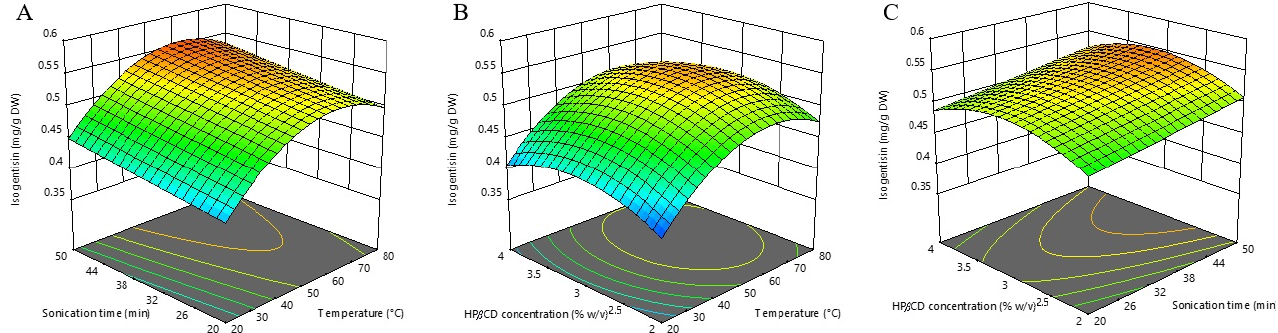
Figure 3. Three-dimensional response surfaces plots of isogentisin as a function of sonication time/temperature ( A ); hydroxypropyl- β -cyclodextrin (HP β CD) concentration/temperature ( B ); and HP β CD concentration/sonication time ( C ).